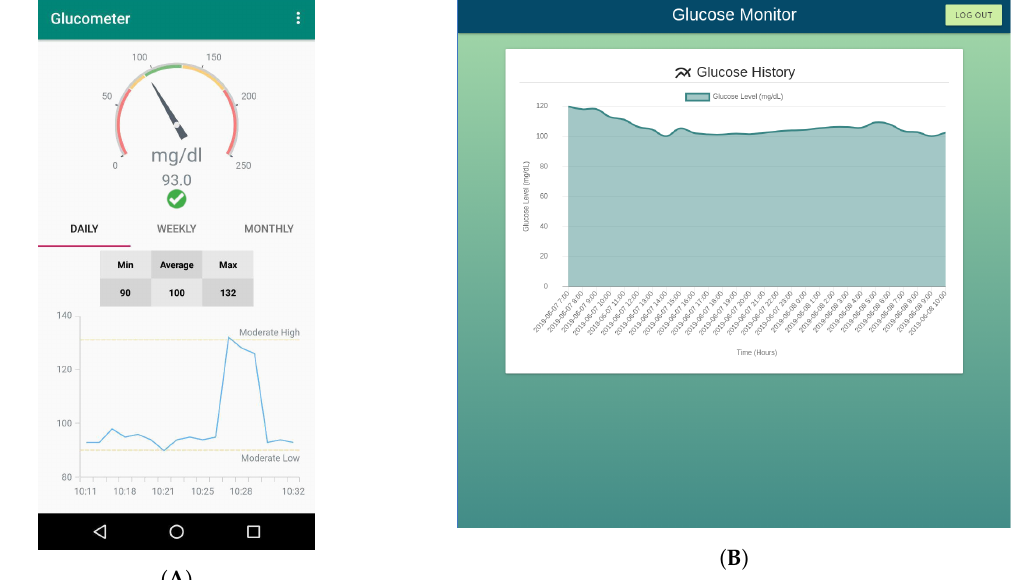
Figure 4. Screenshot of the smartphone app ( A ) and of the web application ( B